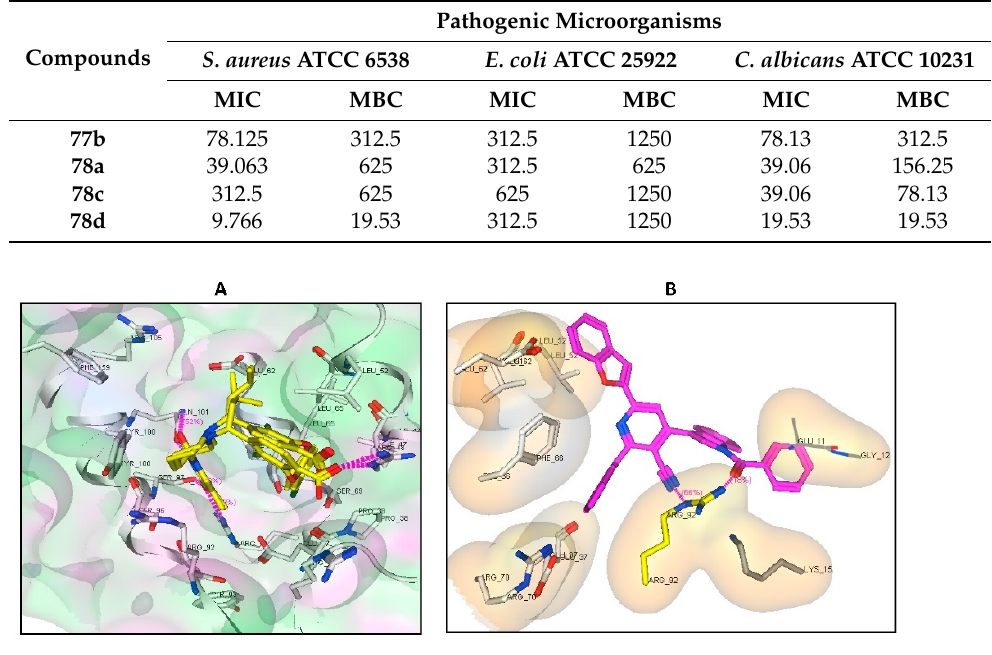
Figure 6. ( A ) The binding mode of the re-docked ligand within the binding pocket of TMPK (ID: 4QGG). The re-docked ligand shows superimposed on the same position as the native ligand (yellow, stick) with the same orientation. The two ligands show the same H-bonds profile with Gln101, Arg48, Arg70, and Ser97 (white, stick). ( B ) The binding mode of compound 78d (pink, stick) within the binding pocket of TMPK (ID: 4QGG). Compound 78d shows π -cation interactions and two H-bound acceptors with the amine acid residue Arg92 (yellow, stick) [38].